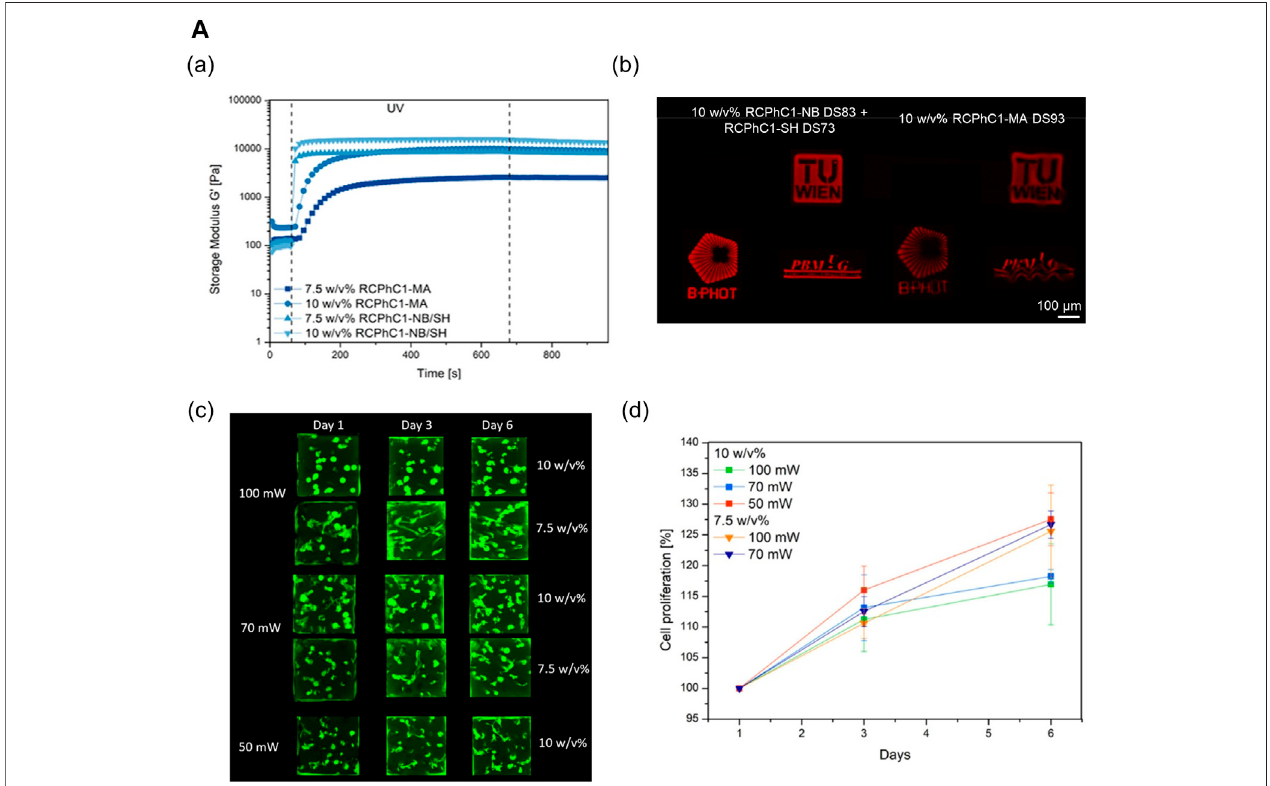
FIGURE 4 | Collagen-based multicomponent bioinks. (A) Characteristics of photocrosslinkable modi fi ed collagen bioink (Methacrylamide-modi fi ed RCPhC1 (RCPhC1-MA), Norbornene-functionalized RCPhC1 (RCPhC1-NB), and Thiolated RCPhC1 (RCPhC1-SH)) (a) Rheological property on 7.5 and 10 w/v % solutions of RCPhC1-NB/SH and RCPhC1-MA in the presence of 2 mol% Li-TPO-L at 37 ° C. (b) Printability test of photocrosslinkable collagen-based bioinks using different logos (TUWien, B-PHOT, and PBM) (leftpanel – 10w/v%RCPh1-NB/SH, rightpanel – RCPhC1-MA).Scalebar:100µm.DS: degreeofsubstitution. (c) Laserscanning microscopy (LSM) images of living ASCs-GFP printed in RCPhC1-NB/SH-based cubes at different polymer concentrations and laser power intensities. (d) Cell proliferation trends as a function of time in cubes printed using RCPhC1-NB/SH at different polymer concentrations and laser power conditions. Reproduced with permission from (Tytgat et al.,